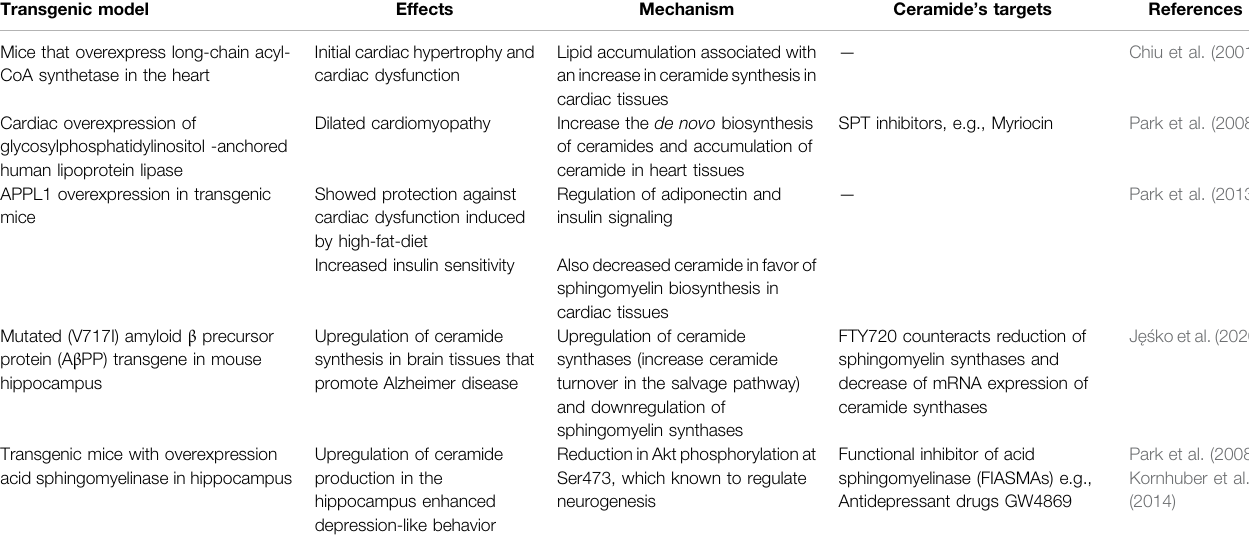
TABLE 4 | Various models for ceramide